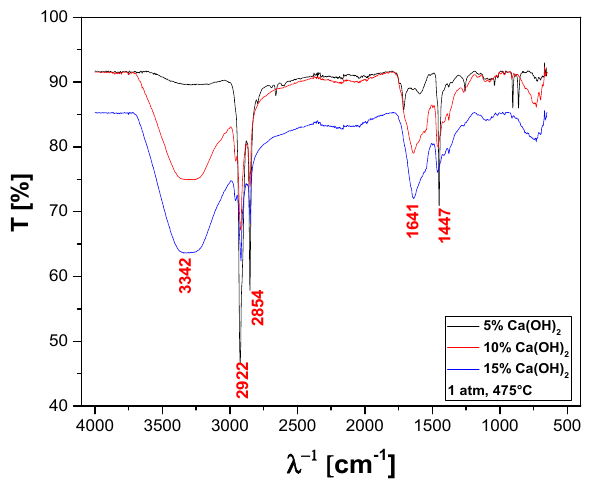
Figure 22. FT-IR of bio-oil obtained by catalytic cracking of MHSW fraction (organic matter + paper) at 475 °C, 1.0 atm, 5.0, 10.0, and 15.0% (wt.) Ca(OH) 2 , in laboratory scale. A wide vibration band was observed between 3600–3200 cm − 1 , characteristic of the O–H angular deformation, associated with the presence of H 2 O. The bands close to 2922 and 2854 cm − 1 refer to the aliphatic axial deformations of the C-H bonds of the methy- lene (CH 2 ) and methyl (CH 3 ) groups. It can also be observed that a stretch that occurs at 1660–1600 cm − 1 , and the conjugation moves the C=C stretch to lower frequencies and increases the intensity. The band of 1447 cm − 1 can be attributed to the stretching of CH 2 bonds. The FT-IT is characteristic of aliphatic hydrocarbons as well as oxygenates,